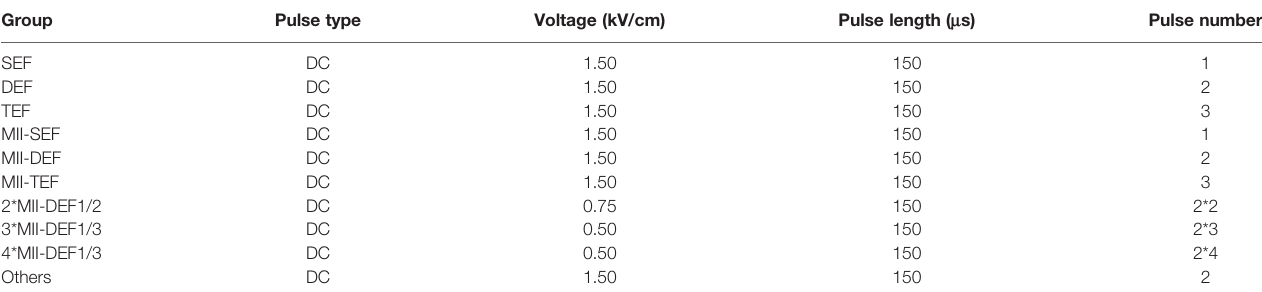
TABLE 1 | Different electrical pulse in each